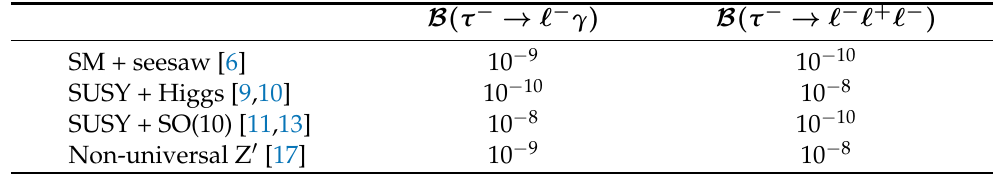
Table 1. The branching fractions ( B ) for τ − → (cid:96) − γ and τ − → (cid:96) − (cid:96) + (cid:96) − decays in some NP